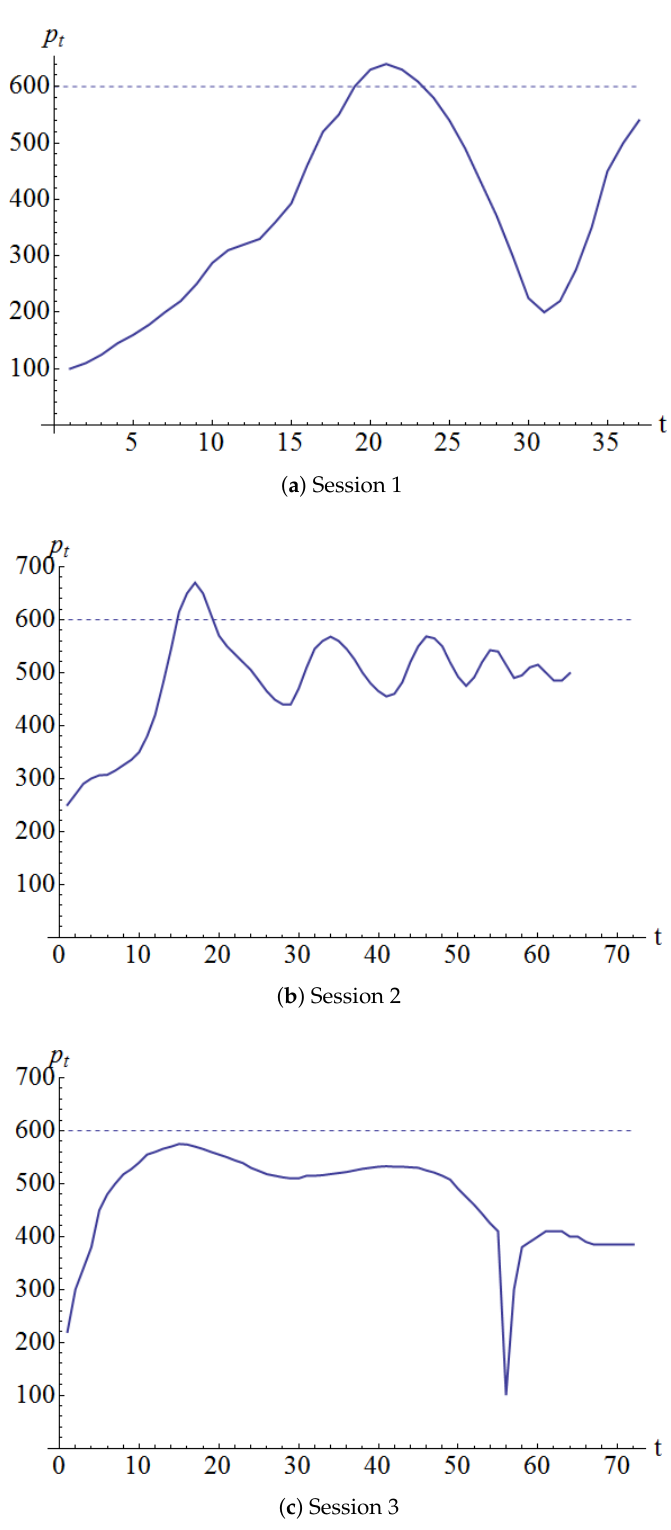
Figure 1. Equilibrium Prices from Sessions 1–3 (Sub-figures ( a )–( c )